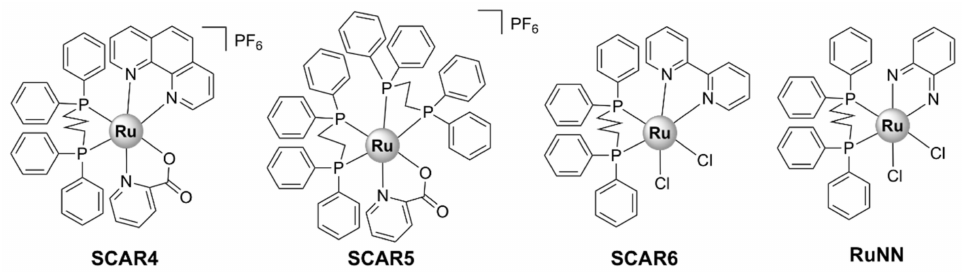
Figure 11. Chemical structures of selected SCAR complexes and